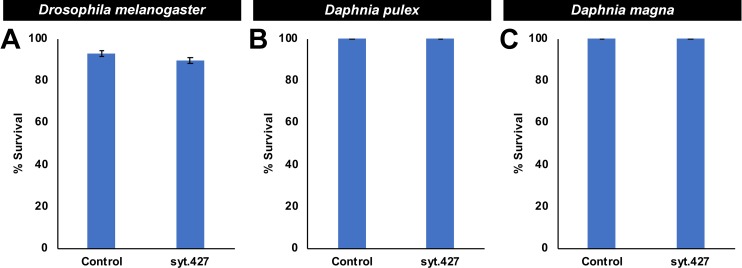
Three non-target arthropods survive syt.427 treatment.Consumption of syt.427 yeast by D. melanogaster larvae (A) did not impact survival through adult emergence (a total of 60 larvae/treatment were assessed in three biological replicate experiments). Consumption of syt.427 by D. pulex (B) or D. magna (C) did not impact adult survival (a total of 30 animals/treatment were evaluated in three biological replicate experiments conducted on each species). Survival data compiled from three replicate experiments and analyzed with the Fisher’s exact test revealed no significant differences in the survival of syt.427- and control-treated organisms. Graphs display mean percentages of survival.